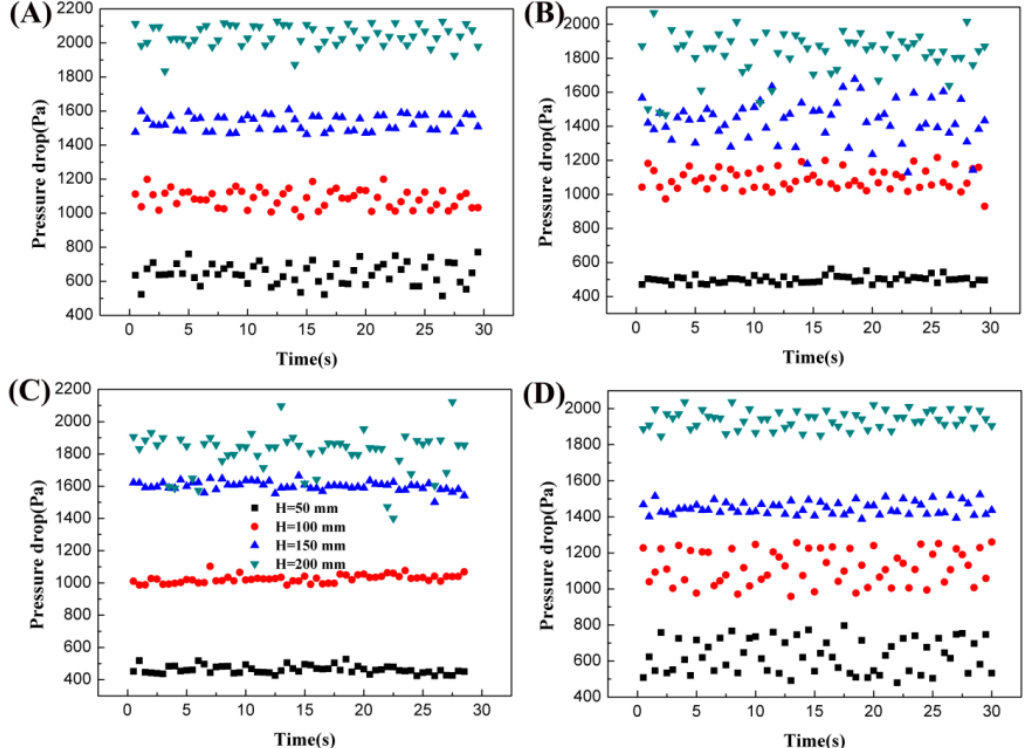
Figure 3. The time evolution of the pressure drop at different bed heights and superficial velocities when the particle size is 0.7 ± 0.1 mm and particle density is 1500 kg/m 3 : ( A ) ν s = 0.0125 m/s; ( B ) ν s = 0.0146 m/s; ( C ) ν s = 0.0167 m/s; ( D ) ν s = 0.0188 m/s.